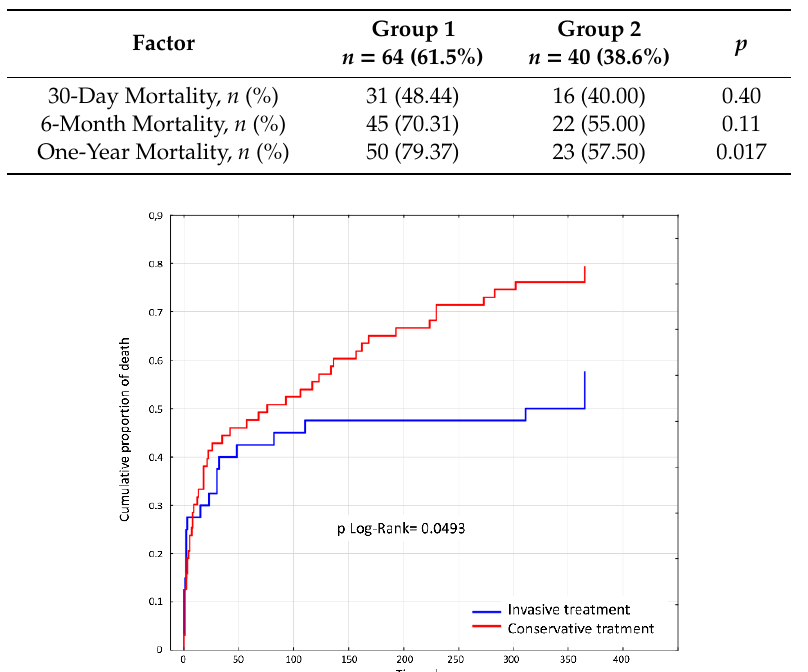
Figure 2. Kaplan–Meier survival curves for 12-month rates of all-cause mortality for the study population.